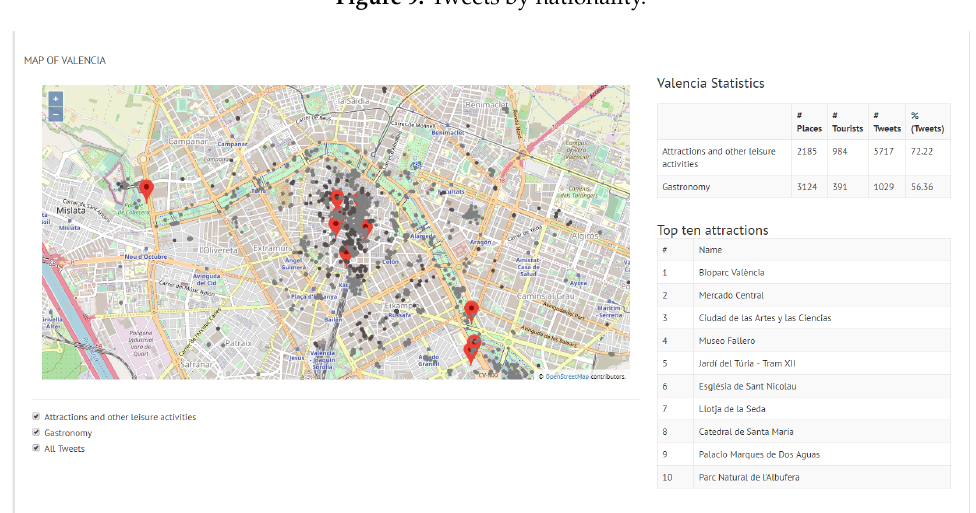
Figure 9. Tweets by nationality.